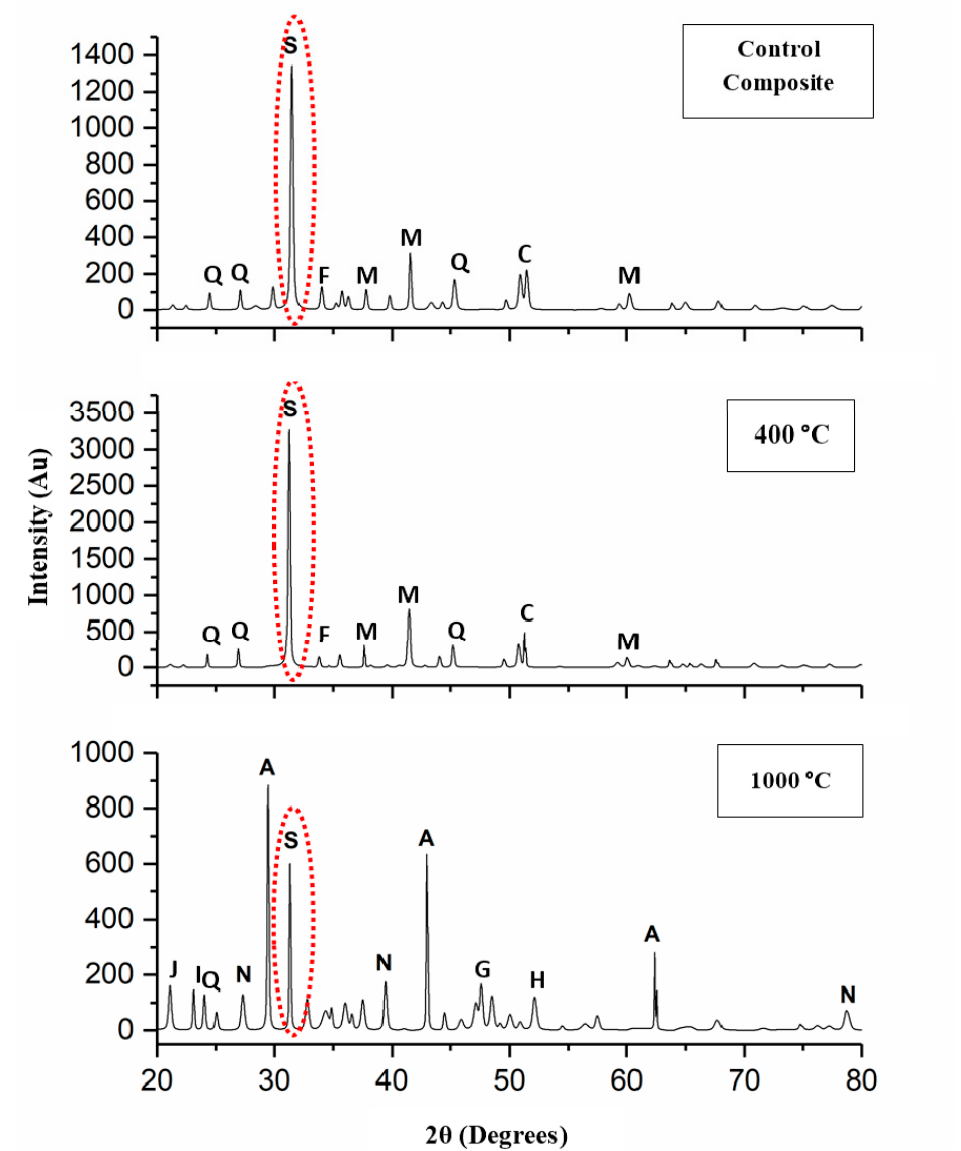
Figure 4. X-Ray Di ff raction (XRD) pattern of dolomite / fly ash geopolymer before (Control) and after Figure 4. X-Ray Diffraction (XRD) pattern of dolomite/fly ash geopolymer before (Control) and after exposure at 400 and 1000 ◦ exposure at 400 and 1000 ° C.